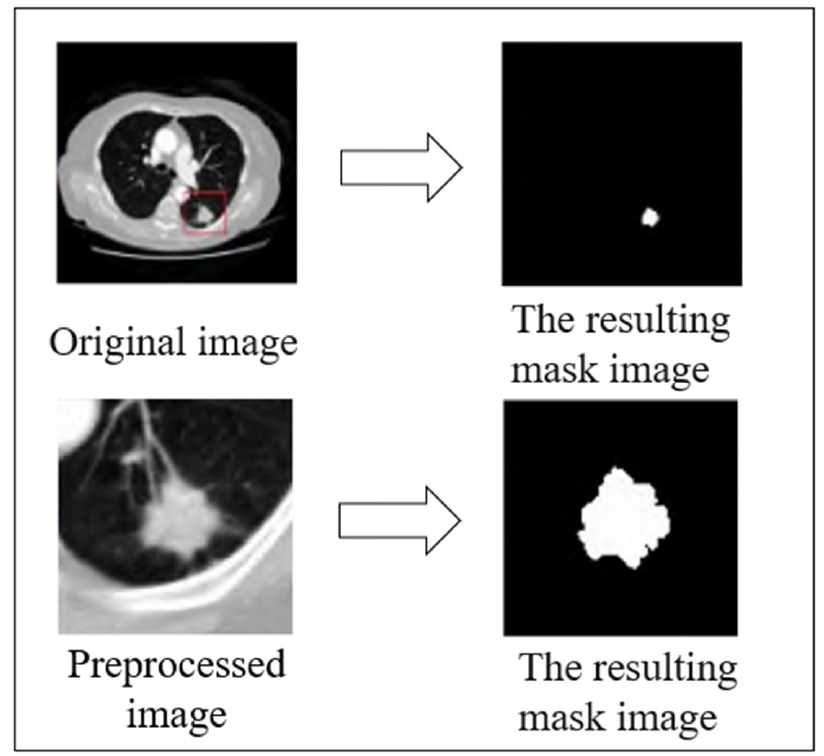
Figure 7. Data preprocessing.